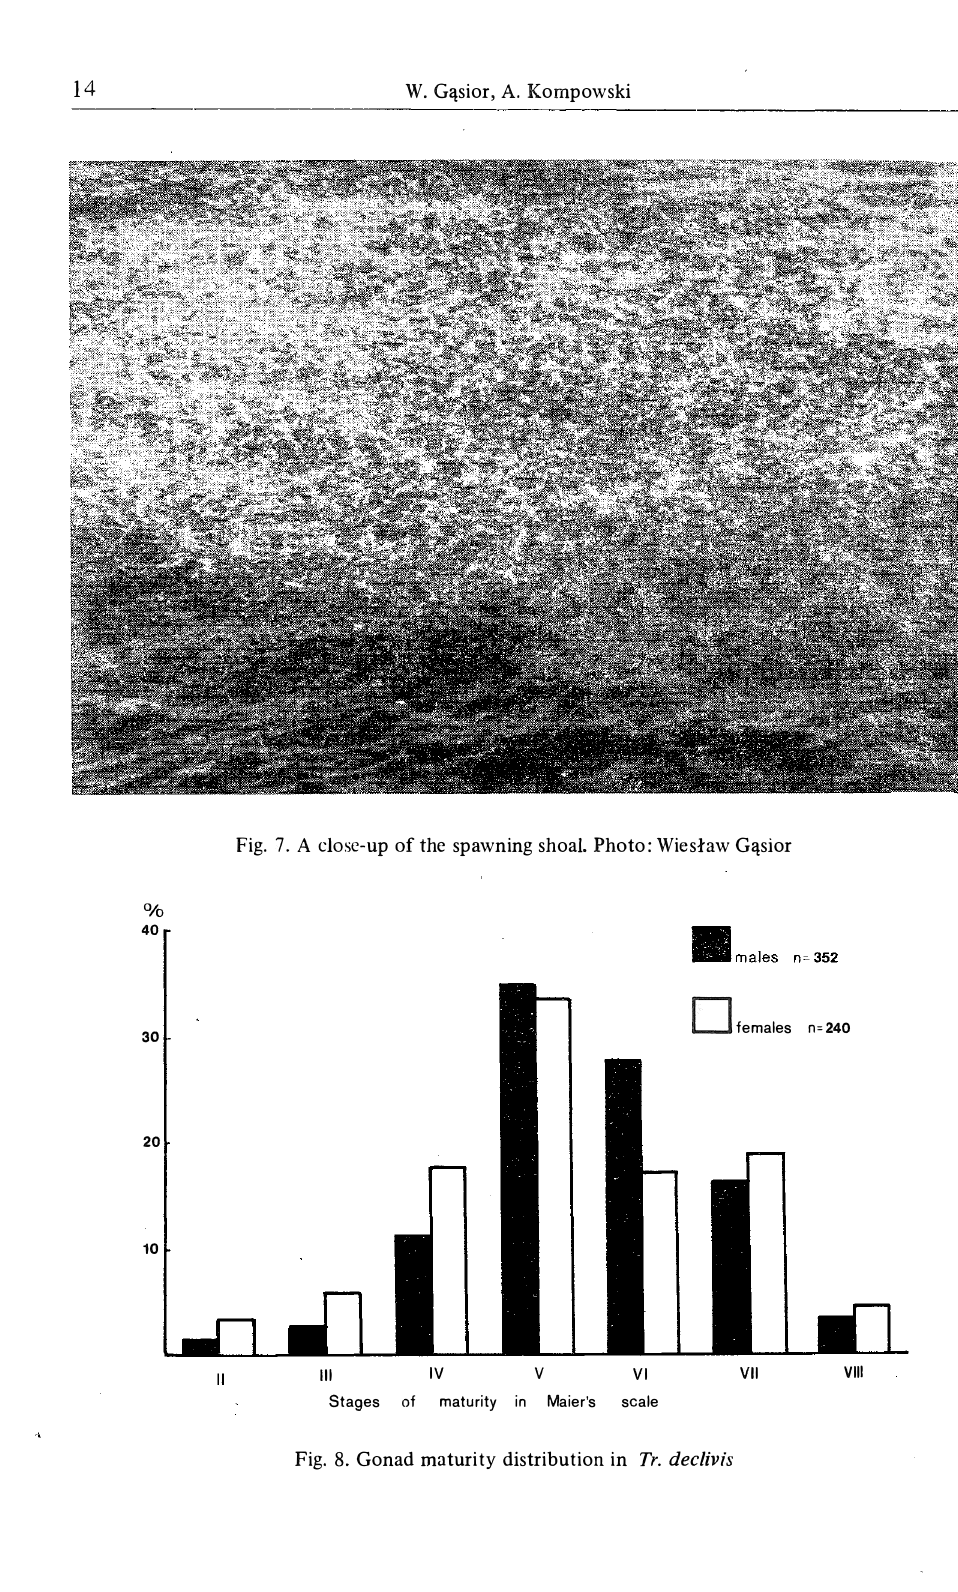
Fig. 7. A dose-up of the spawning shoal. Photo: Wieslaw G<1sior